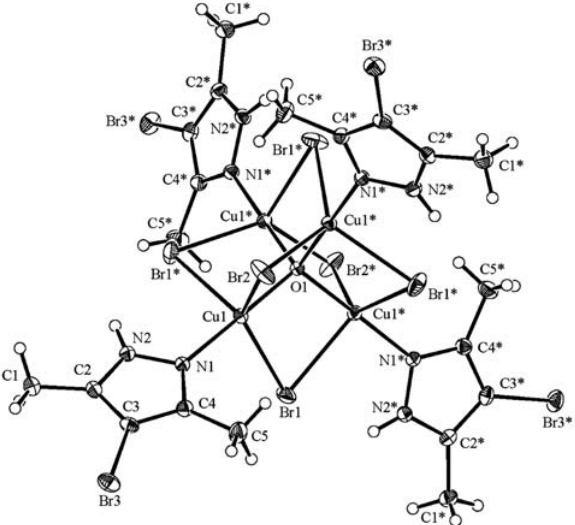
] molecule, Br O(C H N Br) 4 6 5 7 2 4